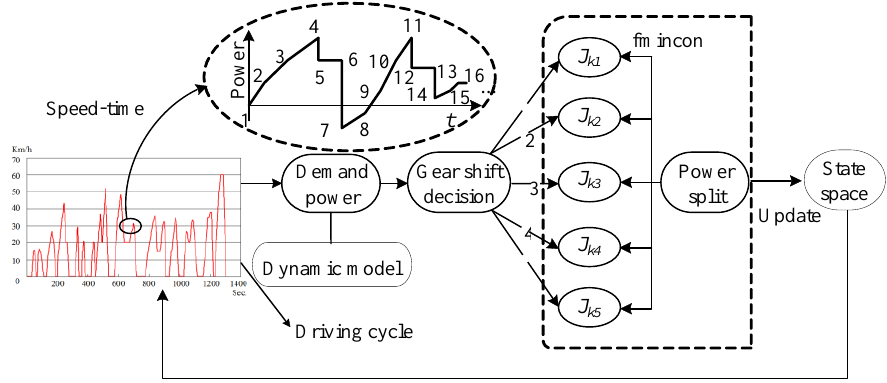
Figure 3 . Schematic of the solving algorithm at time step k . Figure 3. Schematic of the solving algorithm at time step k